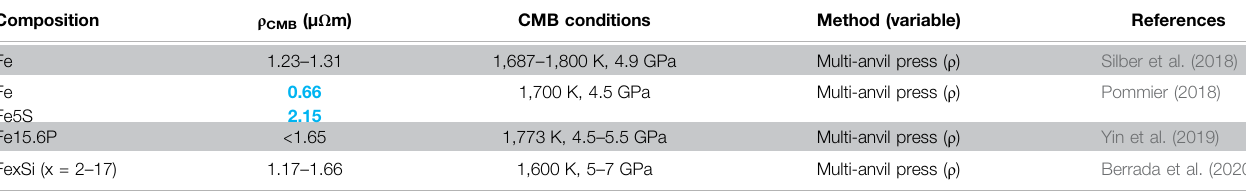
TABLE 5 | Electrical resistivity values of Fe and Fe-alloys according to different methods, at the lunar CMB. Composition